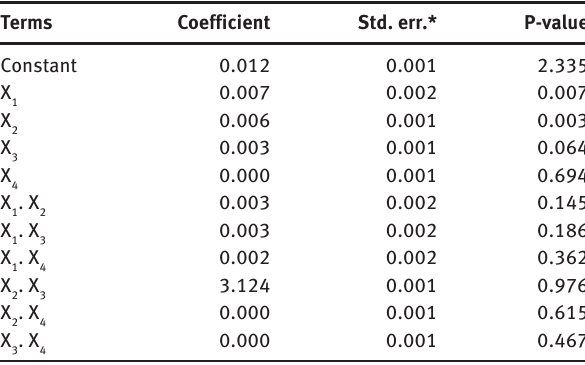
Table 2: Statistical analysis and coefficients of the variables for optimal reaction condition to green synthesis of